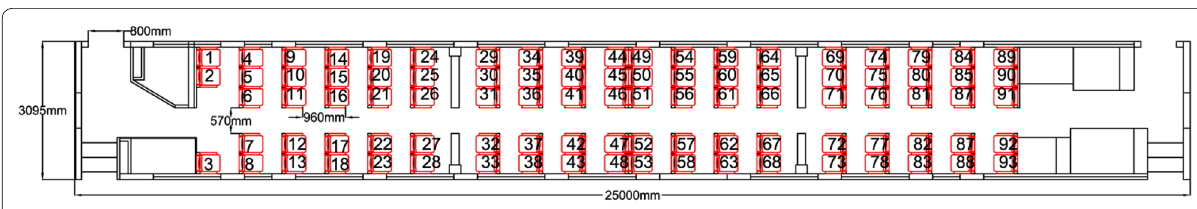
Figure 8 CRH5 second-class car simulation model